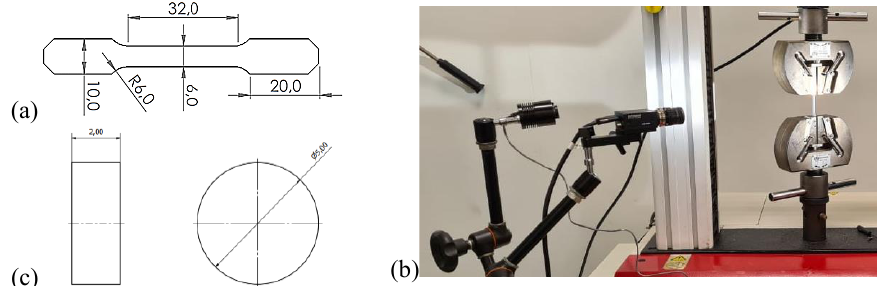
Fig. 1. (a) tensile specimen*, (b) experimental setup used and (c) compressive specimen* (* dimensions in